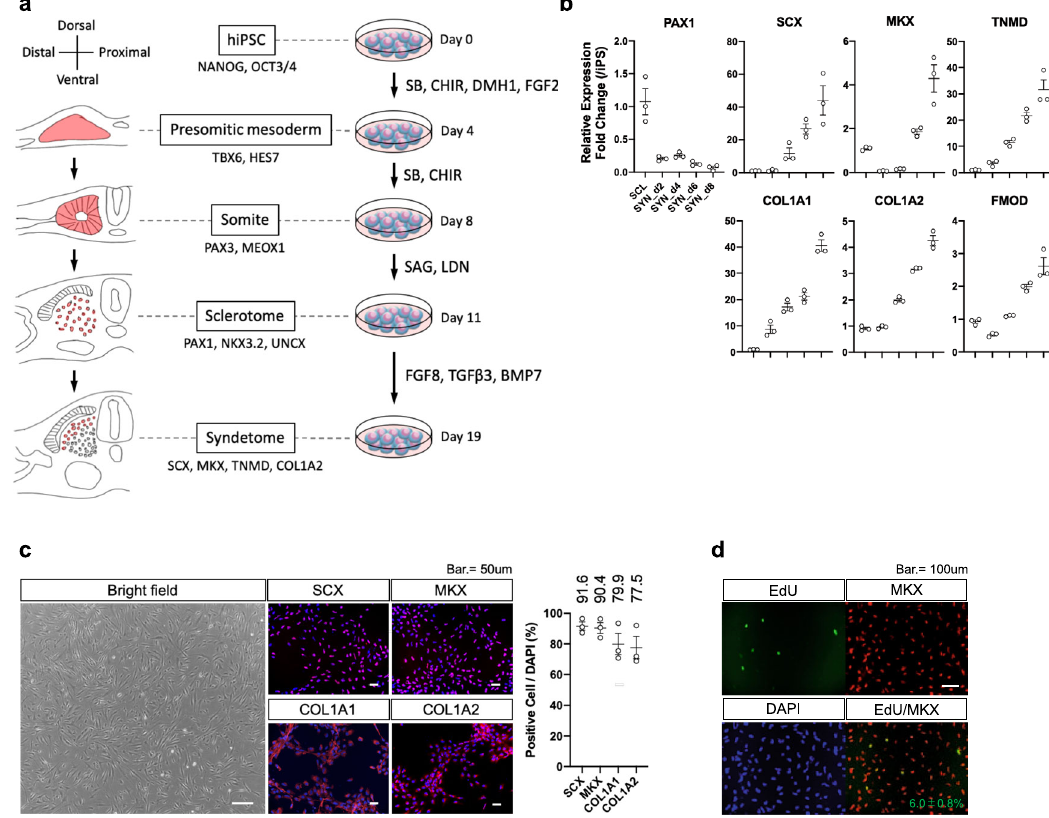
Fig. 1 Robust differentiation of human iPSC-derived syndetome. a Modeling step-wise narrowing fate decisions of syndetome in the embryo with human iPSCs. iPSCs were differentiated toward presomitic mesoderm in medium supplemented with SB, CHIR, DMH1, and FGF2 for four days. Subsequently, day- 4 presomitic mesoderm cells were passaged and differentiated toward somites in medium supplemented with SB and CHIR for another four days. Day-8 somites were then cultured in a medium containing SAG and LDN for sclerotome differentiation. Day-11 sclerotome cells were passaged and subsequently differentiated toward syndetome in medium supplemented with FGF8 and TGF β 3 for the fi rst two days, and in medium supplemented with TGF β 3 and BMP7 for the following six days. b , c Differentiation toward syndetome fate was assessed by RT-qPCR ( b ), bright- fi eld imaging, and immunocytochemistry ( c ). The expression of markers for sclerotome ( PAX1 ) and syndetome ( SCX , MKX , TNMD , COL1A1 , COL1A2 , FMOD ) was assessed by RT-qPCR. Cells were stained with anti-SCX, MKX, COL1A1, COL1A2 antibodies (red) and co-stained with DAPI (blue). Positive rates to DAPI were calculated using Image J. Representative data are shown. Scale bars: 50 μ m. d EdU staining of iPSC-syndetome. iPSC-syndetome were stained with EdU (green) and co-stained with anti-MKX antibody (red) and DAPI (blue). EdU-positive rates to MKX were calculated using Image J. Representative data are shown. Scale bars: 100 μ m. Data represent mean ± SE ( n = 3: biologically independent samples). iPSC, induced pluripotent stem cell; SB, SB431542; CHIR, CHIR99021; LDN, LDN193189. Source data are provided as a Source Data fi (Fig. 2c) and dot plot (Fig. 2d and Supplementary Fig. 2b) ana- lyses to identify the most differentially expressed genes at each time point. We thus identi fi ed several speci fi c markers at appropriate time points, such as OCT3/4 ( POU5F1 ) in iPSCs, DLL3 in PSM, PAX3 in somites, CRABP1 39 in sclerotome, and SCX , COL9A3 , COL3A1 , COL12A1 , and POSTN in syndetome (Fig. 2c). A dot plot of the top 20 genes differentially expressed in syndetome versus sclerotome contained multiple factors known to contribute to tendon healing or tenocyte recruitment (e.g., POSTN , FIBIN , and SPARC ) and the extracellular matrix of tenocytes (e.g., collagens) (Fig. 2d). These results demonstrated that each cell type exhibits proper transcriptional characteristics